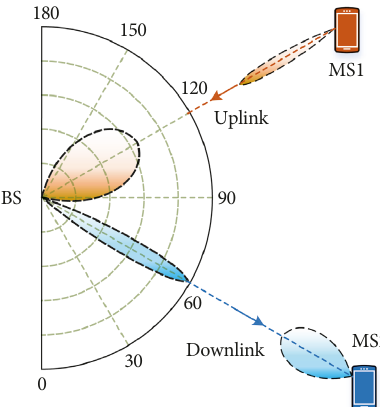
Figure 1: Diagram of the nonreciprocal beam